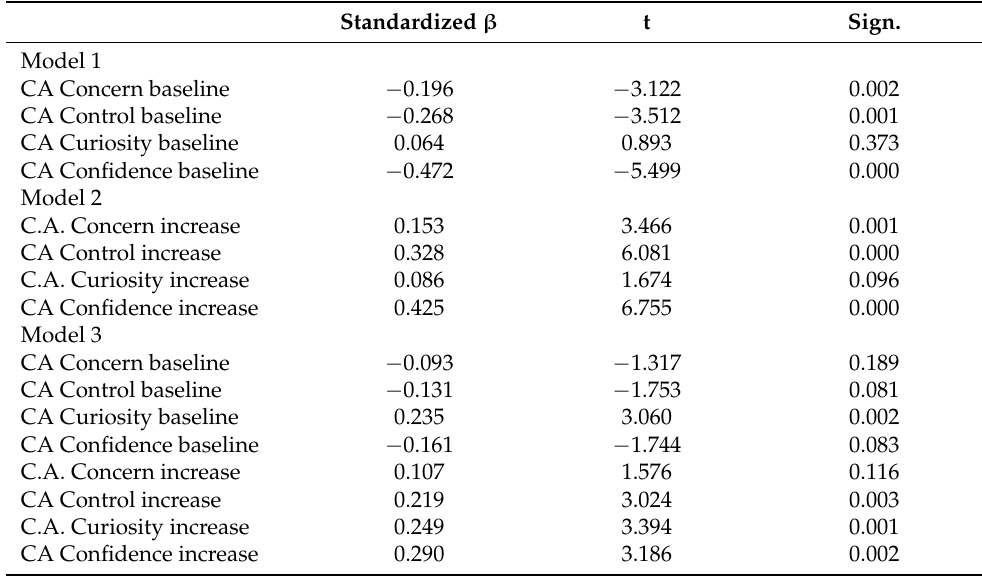
Table 4. Role of career adaptability baseline and increase in explaining WSe.